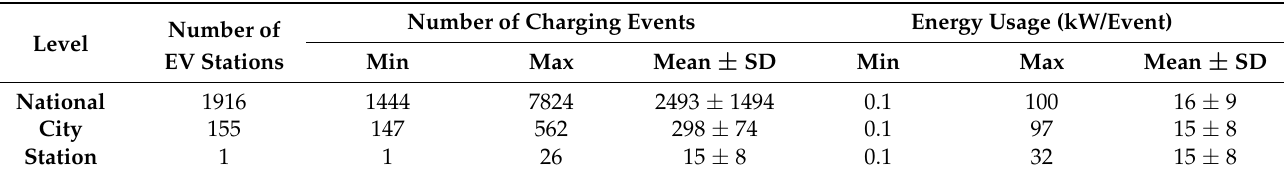
Table 1. Parameter estimations for the classic models at three geographical